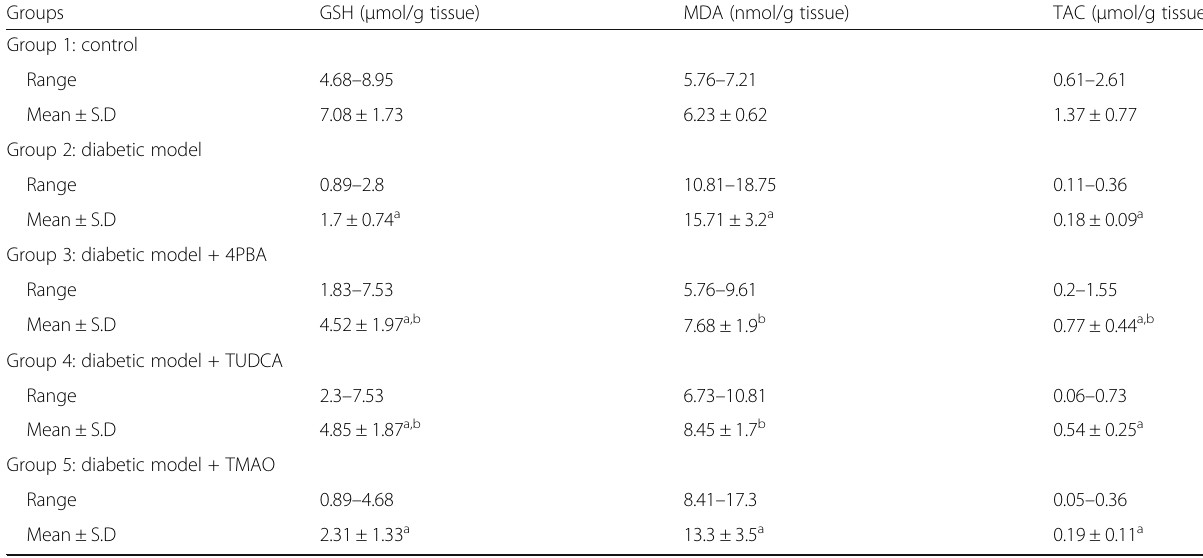
Table 4 Mean values ± S.D. of lens glutathione (GSH), malondialdehyde (MDA), and total antioxidant capacity (TAC) in control and experimental groups